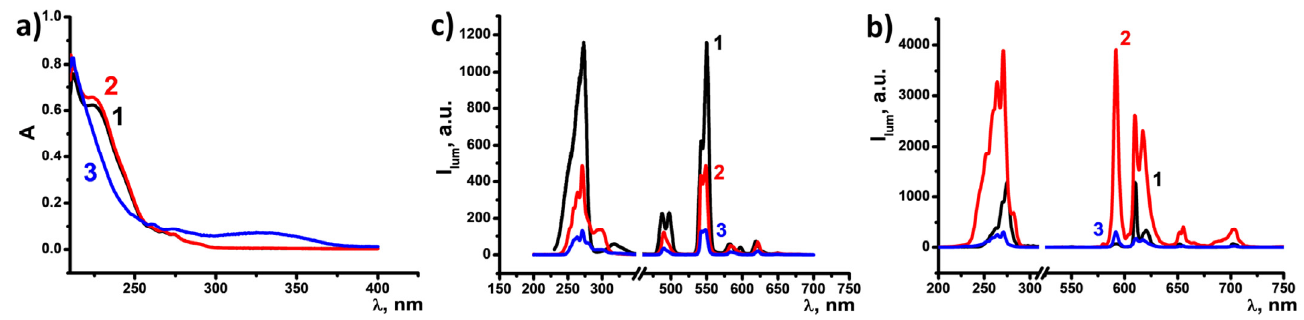
Figure 3. (a) UV-Vis absorption spectra of ligand c (1), c in the presence of triethylamine (2) and c in the presence of triethylamine and an equimolar amount of terbium(III) (C = 10 –5 M). Excitation and emission spectra of [Ln( a ) 3 ] (1), [Ln( b ) 2 (NO 3 ) 3 ] (2), [Ln( c )(NO 3 ) 3 (H 2 O)] (3), (Ln = Tb 3+ (b); Ln = Eu 3+ ( c )) (C Ln = 10 –5 M).